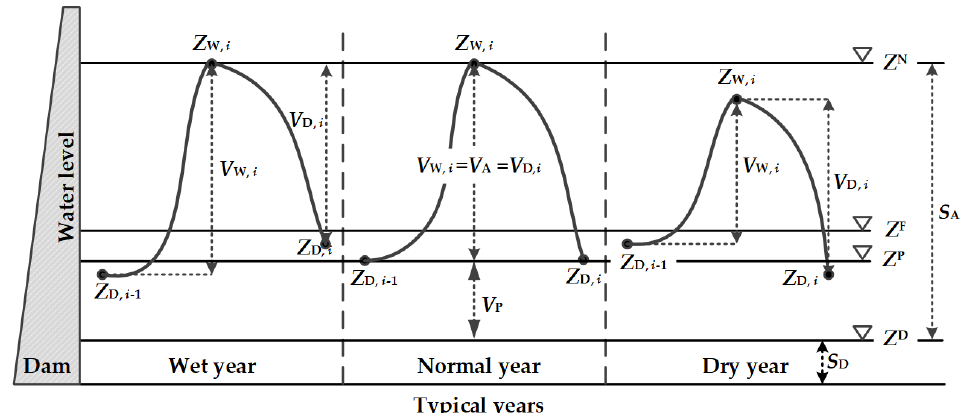
Figure 1. Diagrammatic sketch of the PL, WL, and DL of an MRS reservoir. (Note: Z N , Z F , and Z D are the normal water level, the flood limit water level, and the dead water level, respectively; Z P denotes the PL; Z W, i and Z D, i represent the WL and the DL of the i th year, respectively; V W, i and V D, i denote the increased WSV in the wet season and the reduced WSV in the dry season at the i th year, respectively; V A and V P represent the annual and the perennial storage spaces, respectively; and S D and S A denote the dead and the active storage spaces, respectively).